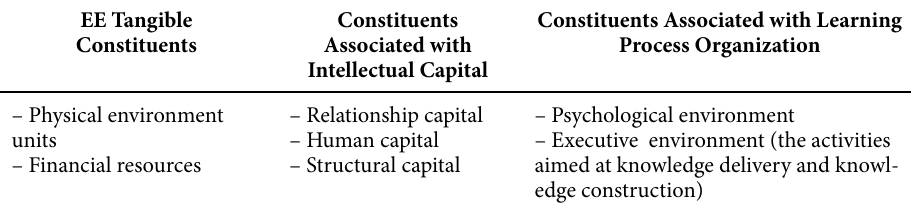
Table 3. Tangible, semi-tangible and intangible constituents of the internal educational